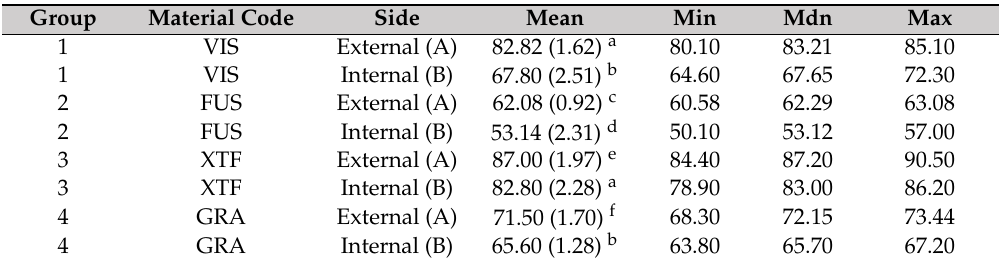
internal side of the samples.